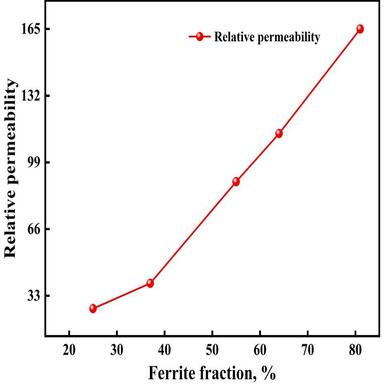
Relative permeability under different phase fraction (ferrite–austenite) models.